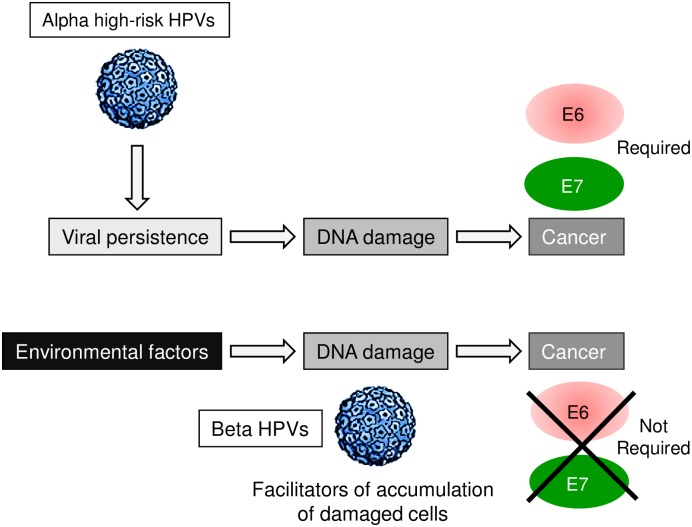
Schematic representation of well-known and hypothetical models of virus-associated carcinogenesis.